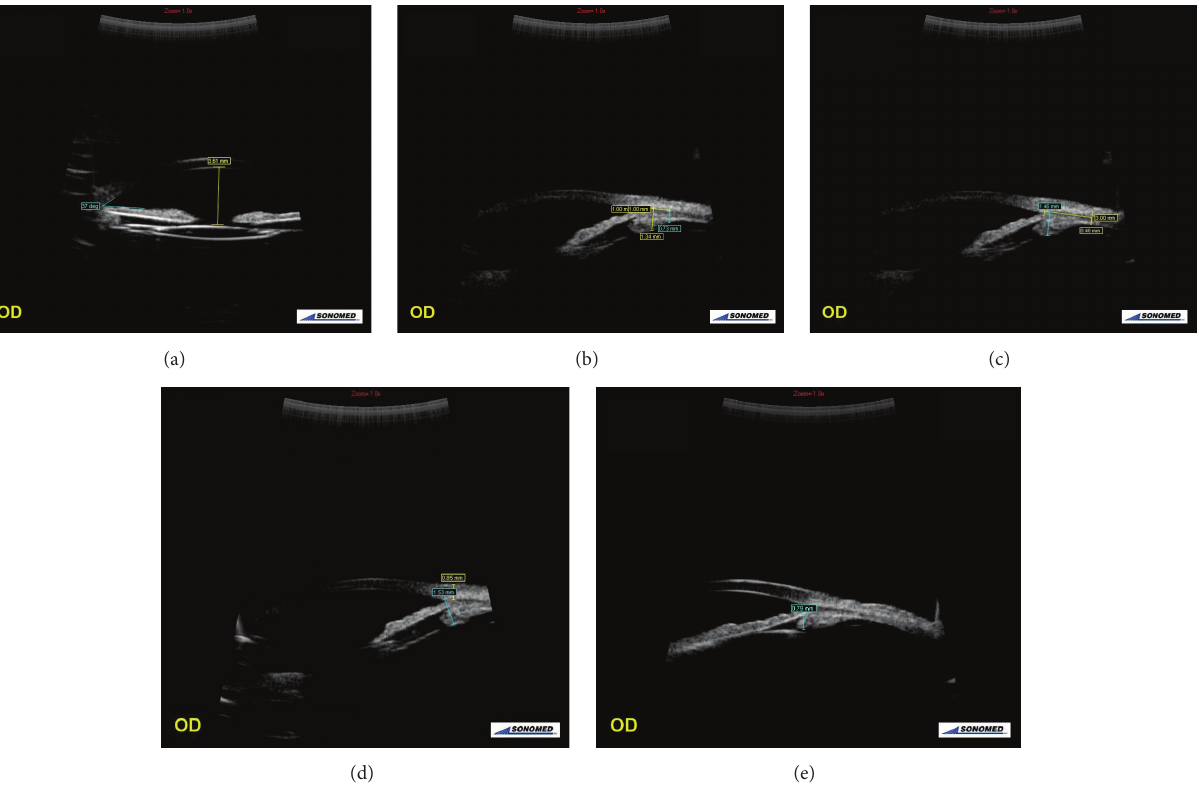
Figure 1: Views of axial images of the anterior chamber and radial section of the angle images from the temporal quadrant. (a) An UBM image of anterior chamber depth (ACT) and trabecular meshwork-iris angle (TIA). (b) An UBM image of ciliary body thicknesses 1 and 2 (CBT 1 and 2). (c) An UBM image of ciliary body thickness 3 (CBT 3) and the maximum ciliary body thickness (CBT Max). (d) An UBM image of scleral thickness (ST) and trabecular-ciliary process distance (T-CPD). (e) An UBM image of iris-ciliary process distance (I-CPD).